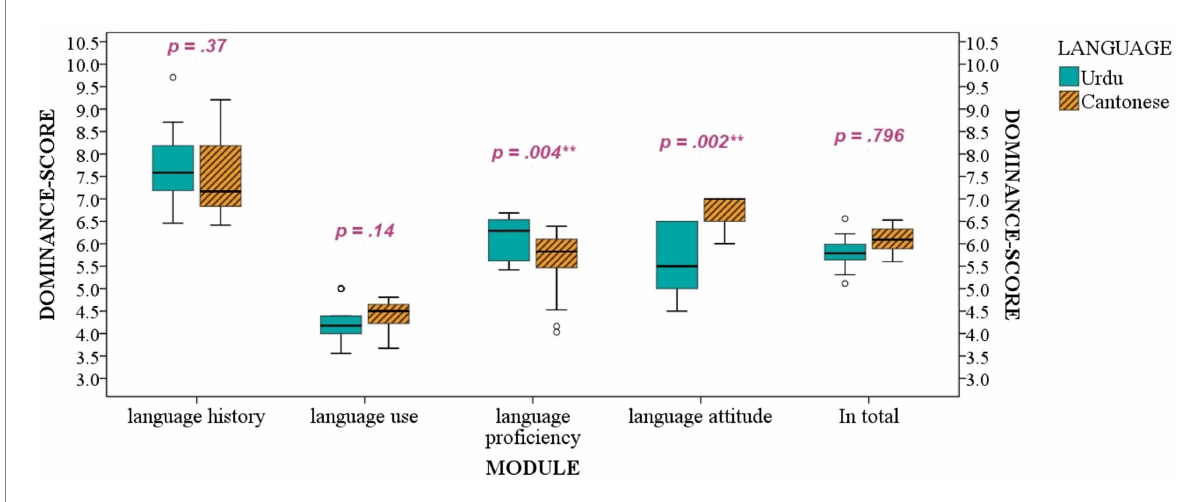
FIGURE 1 The dominance scores based on BLP calculating method (Birdsong et al., 2012). T -test results between Cantonese and Urdu were shown on the chat.